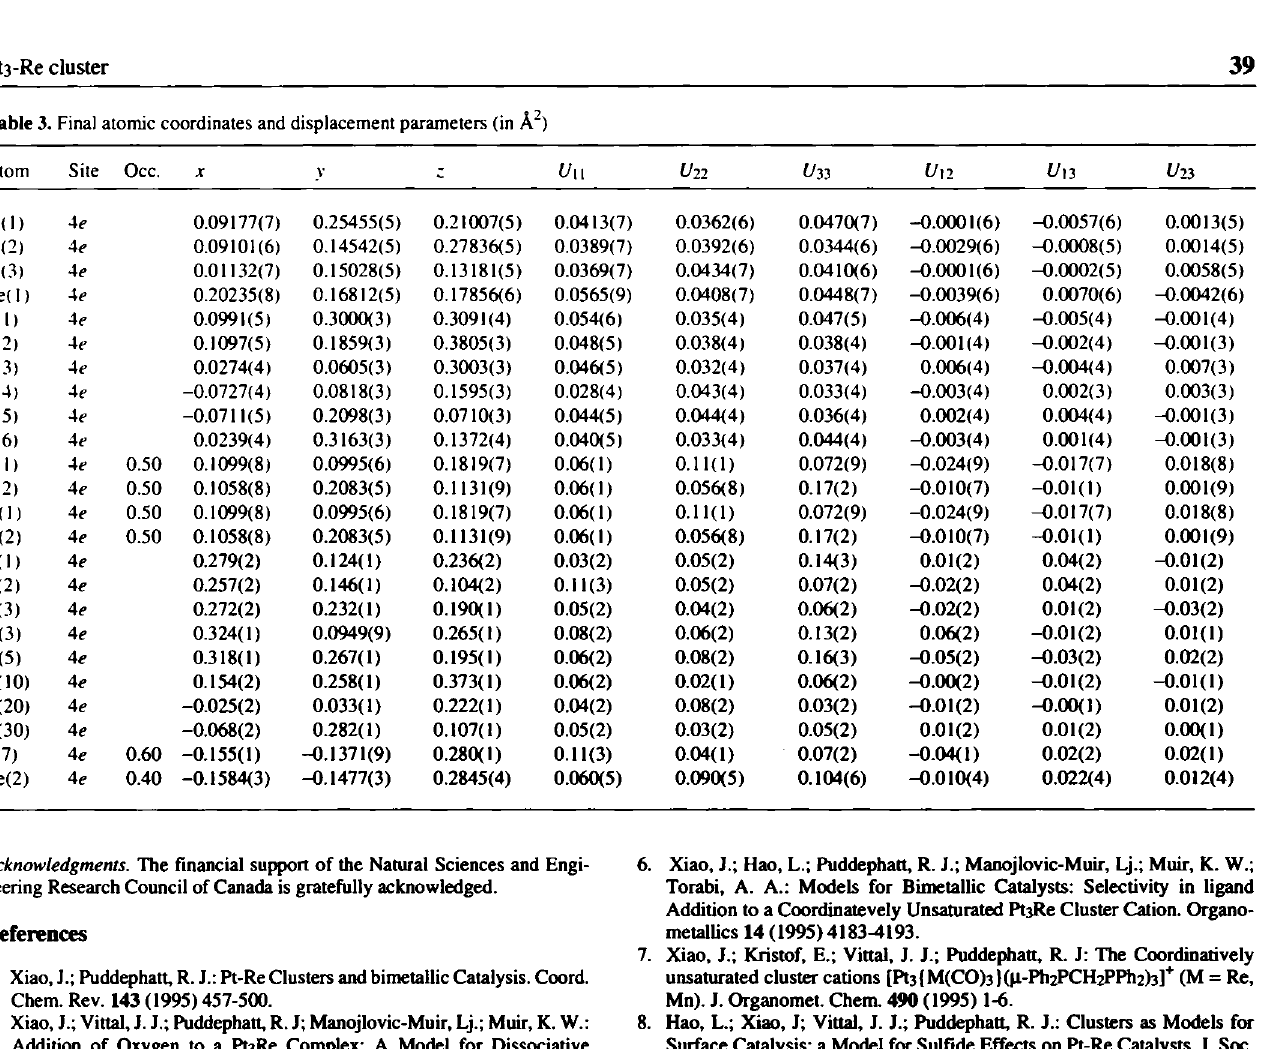
Table 3. Final atomic coordinates and displacement parameters (in A") Atom Site